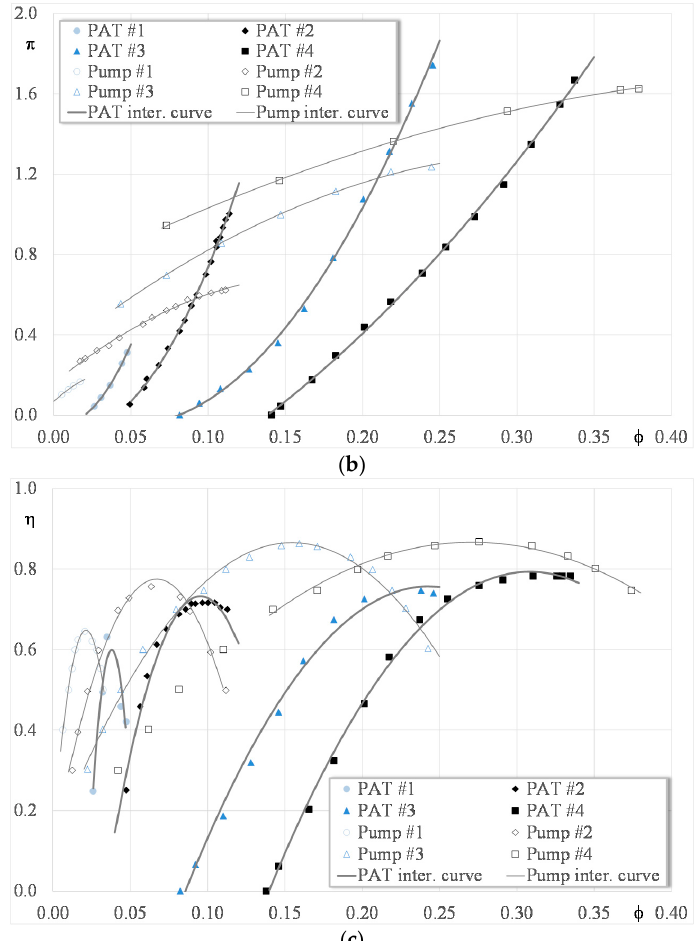
Figure 1. ( a ) Non-dimensional head vs. non-dimensional volume flow rate; ( b ) Non-dimensional power vs. non-dimensional volume flow rate; and, ( c ) Efficiency vs. non-dimensional volume flow rate (symbols: experimental data reported in [11]; lines: interpolation curves).